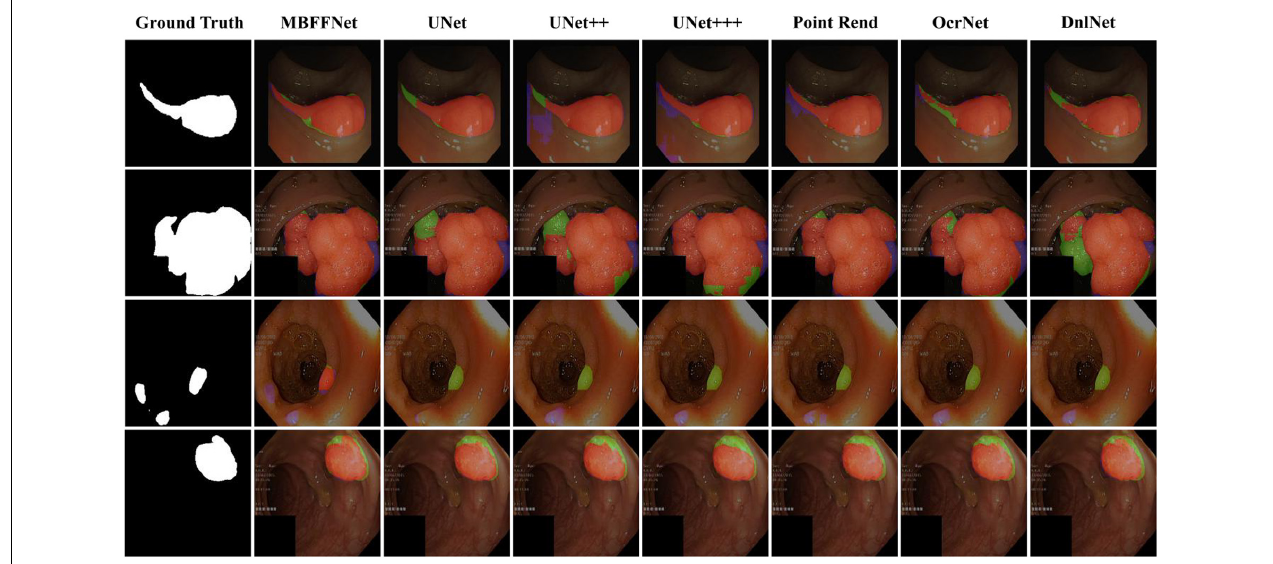
FIGURE 5 | Comparison of model effect. The red represents True Positive (TP), indicating that the predicted polyp area is actually a polyp area. Blue represents False Positive (FP), indicating that the predicted polyp area is actually a non-nuclear area. The green represents FN (False Negative), which means that the predicted polyp area is actually a polyp area.